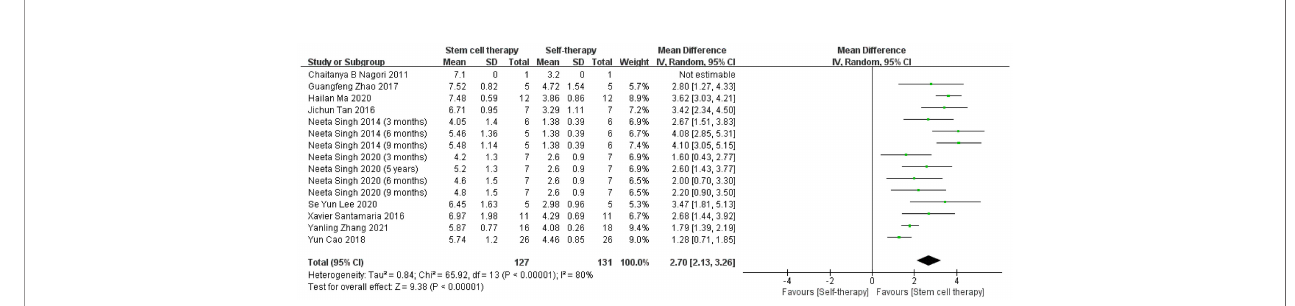
FIGURE 5 | Endometrial thickness